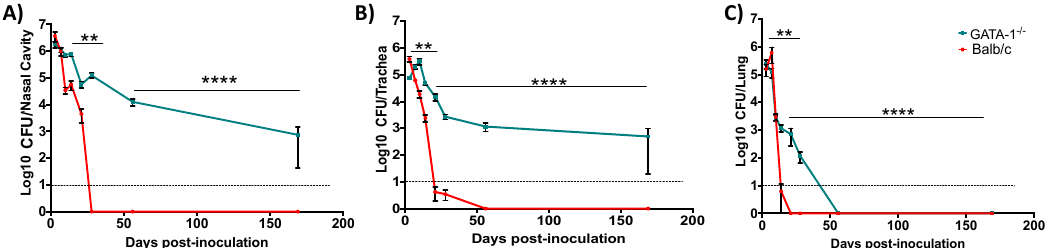
Figure 2. Eosinophil-deficient mice failed to clear bacterial infection from the respiratory tract. Balb / cJ—WT (wild-type) (red) or DdblGATA-1—EO - (eosinophil-deficient) (green) mice were intranasally challenged with 50 µ L of PBS containing 5 × 10 5 Bb D btrS . At di ff erent days, mice were euthanized, and colonies were enumerated in the nasal cavity ( A ), trachea ( B ), or lungs ( C ). The graphs show the average and SEM. ** p < 0.01, **** p < 0.0001, using two-way ANOVA test. This experiment was conducted multiple independent times, to compensate for possible e ff ects of times of the year and spontaneous allergic reactions on eosinophils counts. n = 22.